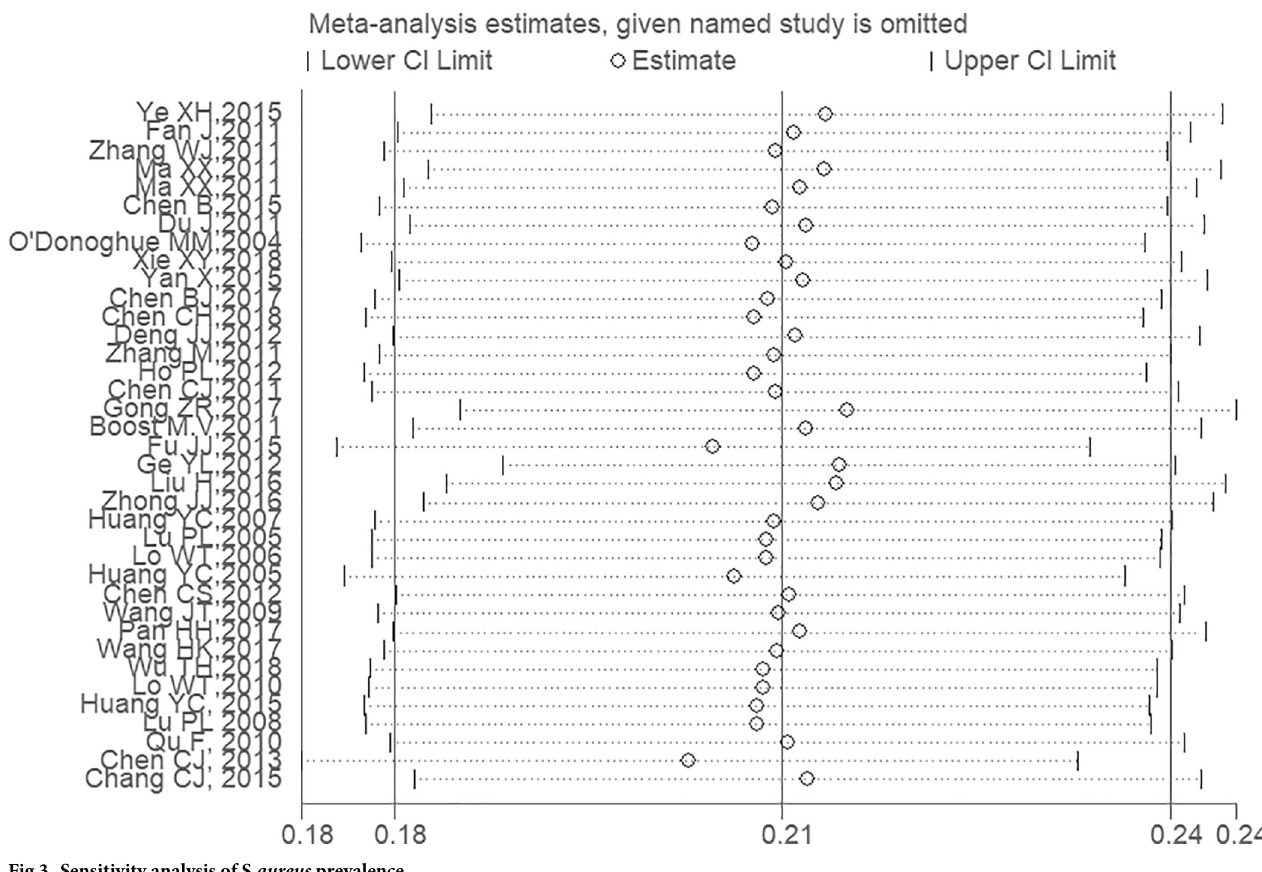
Fig 3. Sensitivity analysis of S. aureus